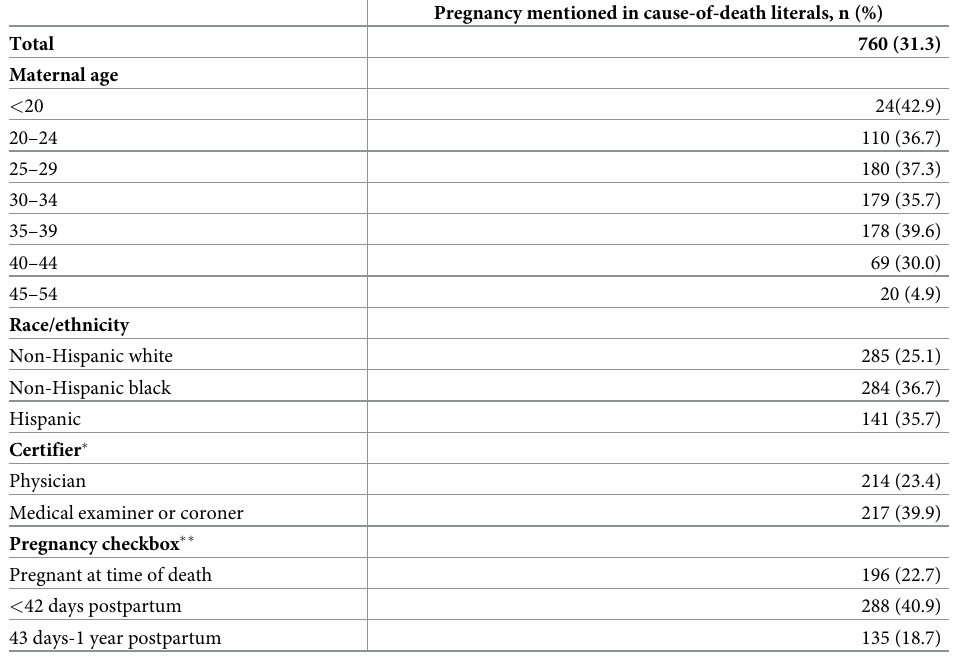
Table 3. Number and percentage of maternal and late maternal deaths with pregnancy mention in cause-of-death literals by selected variables, United States,